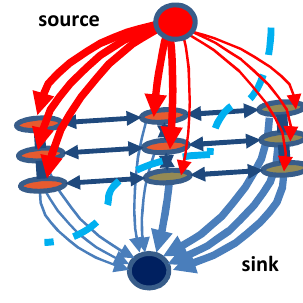
Figure 2. Minimum-cut on a graph (reproduced from Boykov and Veksler,